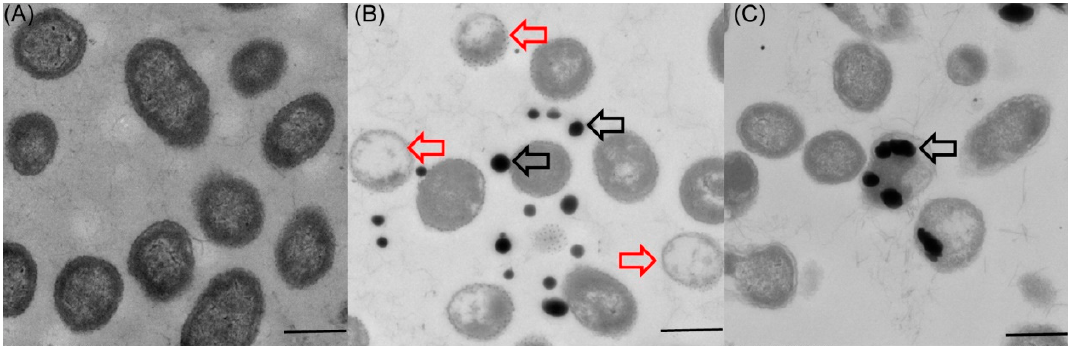
Figure 4. Transmission electron microscopy (TEM) images of P. mirabilis YC801 grown without Na 2 SeO 3 ( A ) and with 5 mM Na 2 SeO ( B , C ) after 36 h incubation. Electron-dense nanoparticles (white arrows) are located extracellularly ( B ) or intracellularly ( C ). The red arrows indicate “empty ghost” cells. The bar represents 1 μ m.